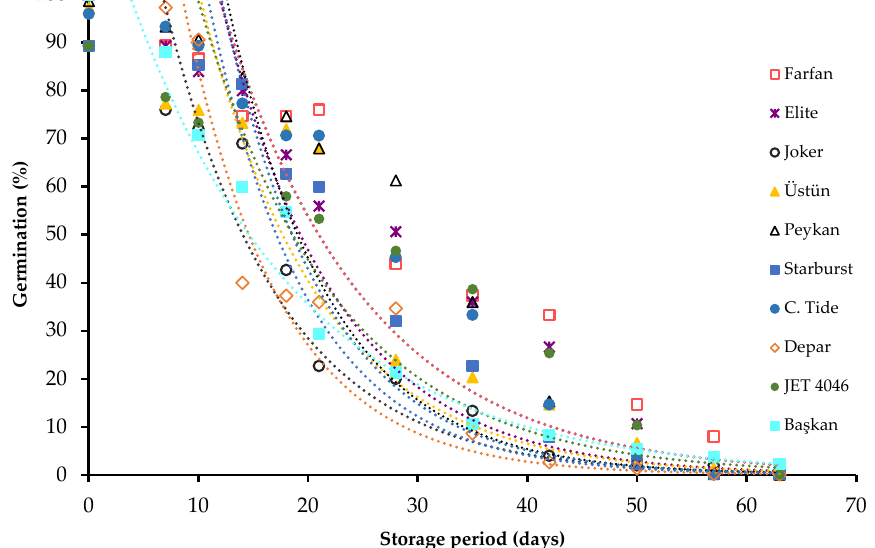
Figure 3. Survival curves of the seeds of ten watermelon hybrid cultivars stored at 35 ± 2 °C and 17% of seed moisture over 63 days. Correlation coefficient values between RE counts and Ki and P 50 showed that RE counts of 42 h had a highly significant relationship (r = 0.7383–0.7936, p < 0.01) in both criteria. There are some other significant relationships as well, but these are at a lower level ( p < 0.05) than that of 42 h (Table 3). RE at 42 h was not related to pre-storage normal germination percentages (Figure 4). RE counts at 42 h varied between 9% and 91%, while normal germination before storage was very high. Therefore, RE 42 h greatly varied, but normal germination percentages did not. However, RE 42 h was related to changes in Ki P 50 . Table 3. Correlation coefficients of RE count between 34 h and 60 h and probit values of Ki and P 50 (days) for seed lots of ten hybrid watermelon cultivars. Significance: * is 0.05, and ** is 0.01. Time of RE Count (h)